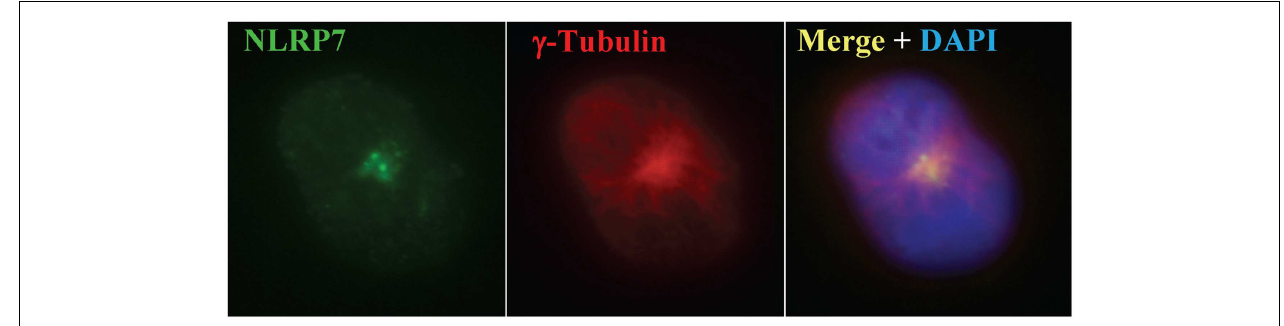
FIGURE 4 | NLRP7 expression in monocytes using immunofluorescence . NLRP7 stains two small dots specific for the microtubule organizing center, which is also revealed with γ -tubulin as previously reported